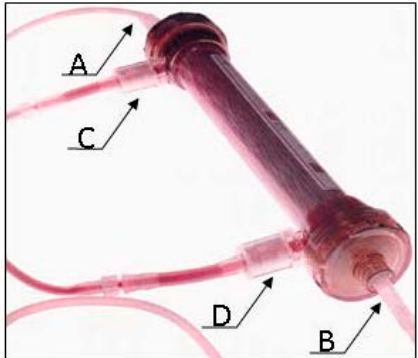
Figure 2. Renal Assist Device (RAD), containing human renal tubule cells (RTC) is part of the two circuit system: a standard hemofilter and a bioreactor (RAD). The ultrafiltrate produced by the hemofilter enters the RAD lumen (A) upon which the RTC have been grown, and then discarded (B); The blood from the hemofilter enters the extracapillary space of the hollow fiber cartridge (C); in the RAD, the blood is separated from the RTC by the semipermeable hollow fiber membrane and returned to the patient (D).